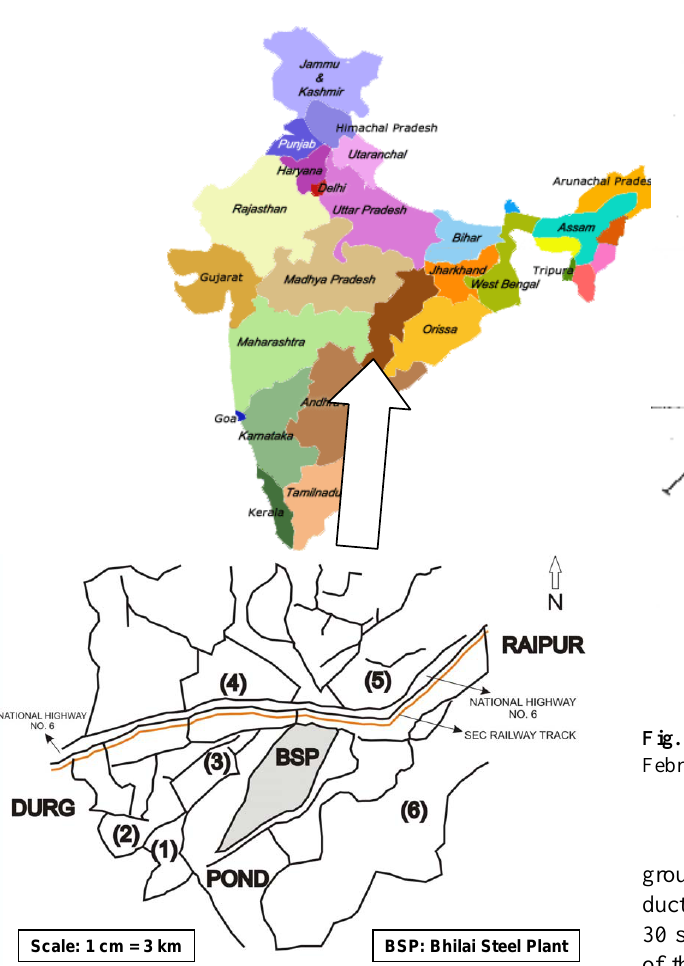
Fig. 01: Location map of air sampling sites for monitoring of ambient mercury around integrated steel plant, Bhilai, India Scale: 1 cm = 3 km BSP: Bhilai Steel Plant